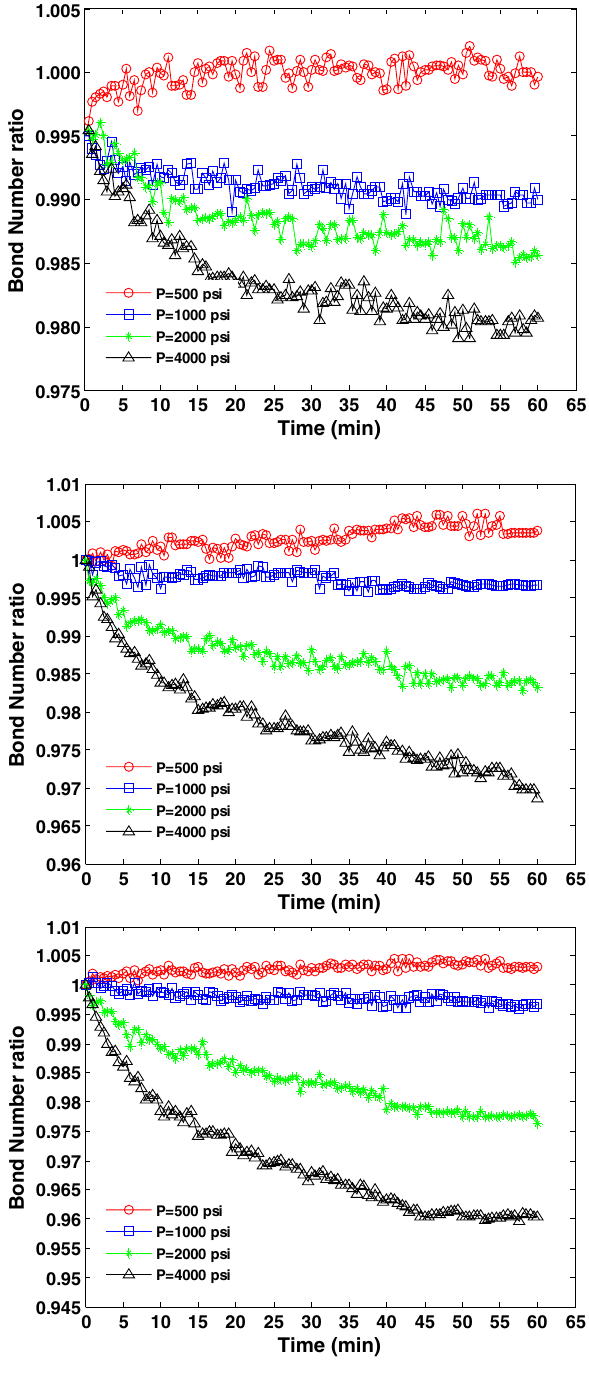
Fig. 5 Dynamic Bond number ration of crude oil in the presence of 15,000 ppm of MgSO 4 at temperature of a T = 30 °C, b 50 °C, and c 80